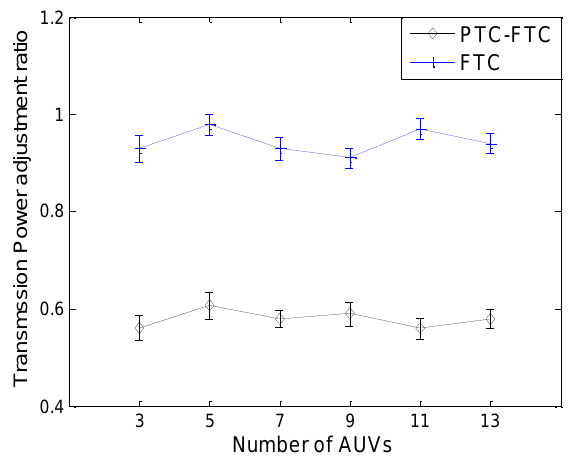
Figure 11. The average transmission power adjustment probability of PTC-FTC.